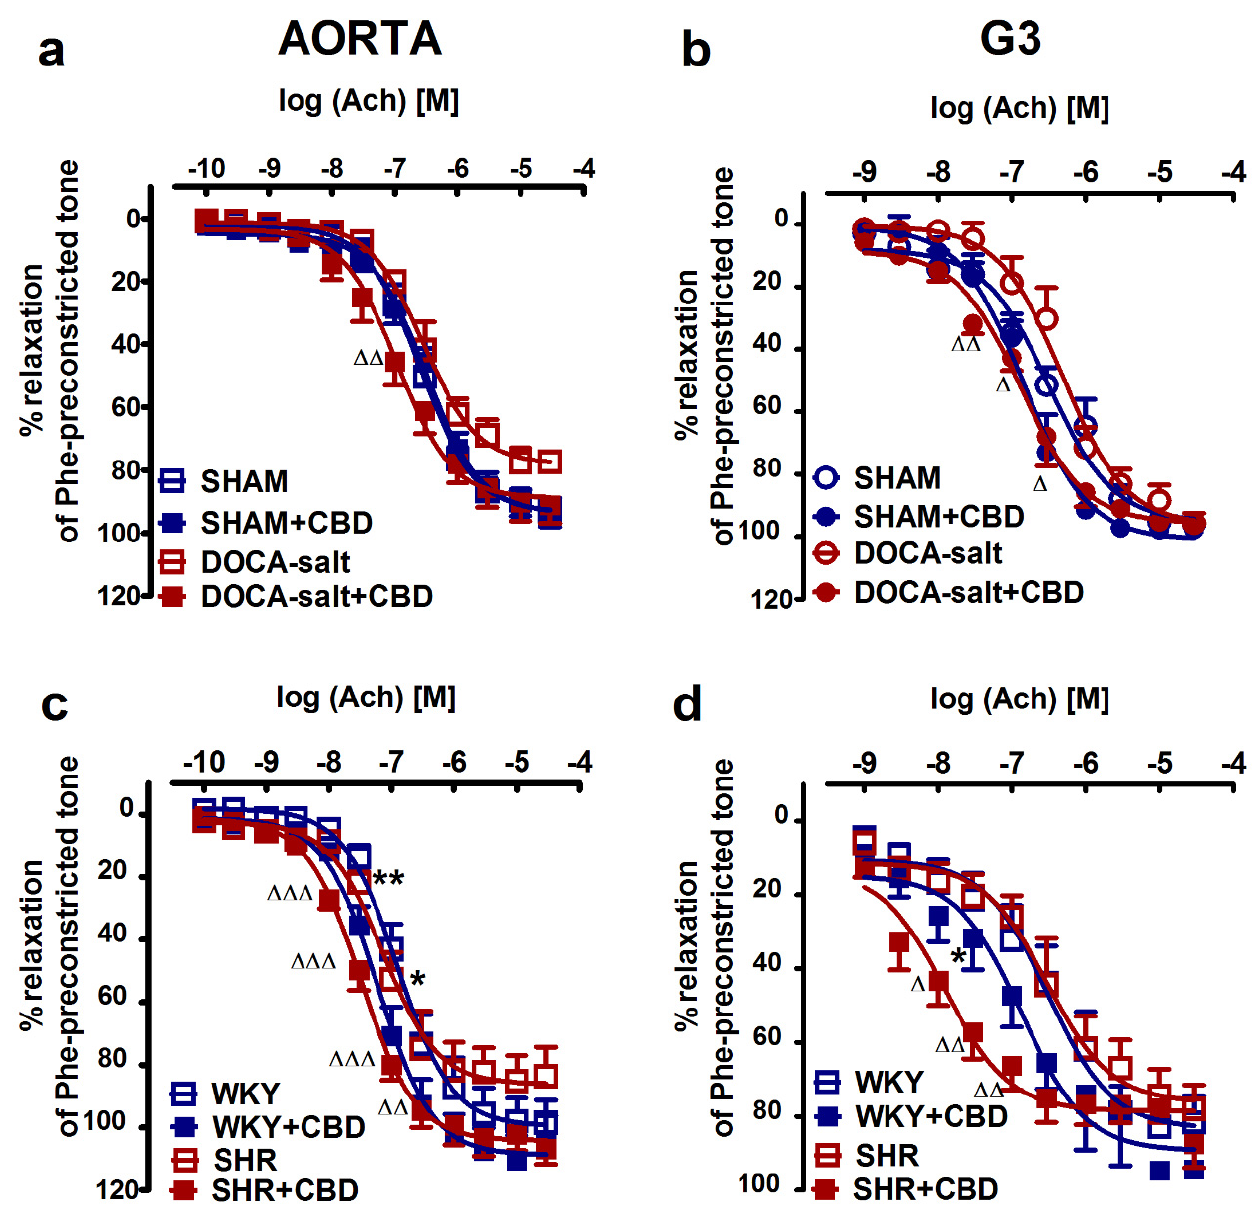
Figure 1. Influences of cannabidiol (CBD) and its vehicle on the vasorelaxant effects of acetylcholine (Ach) in aortas ( a , c ) and the mesenteric G3 arteries ( b , d ) isolated from deoxycorticosterone-induced (DOCA-salt) and spontaneously (SHR) hypertensive rats and their normotensive controls, sham-operated (SHAM) and Wistar–Kyoto (WKY) rats, respectively. CBD (10 mg/kg) or its vehicle was injected i.p. every 24 h for 14 days. Vasodilatory responses are shown as percentages of the reference response of the isometric contraction induced by phenylephrine (Phe). Mean ± SEM of n = 5–8 tissues for each curve. * , ∆ p < 0.05, ** , ∆∆ p < 0.01 and ∆∆∆ p < 0.001 compared to the respective control groups (* SHAM/WKY or ∆ DOCA-salt/SHR), as determined by one-way ANOVA, followed by Bonferroni’s multiple-comparison tests. In a few cases, the SEM is smaller than or equal to the size of the symbol. See Tables 1 and 2 for statistical analysis.